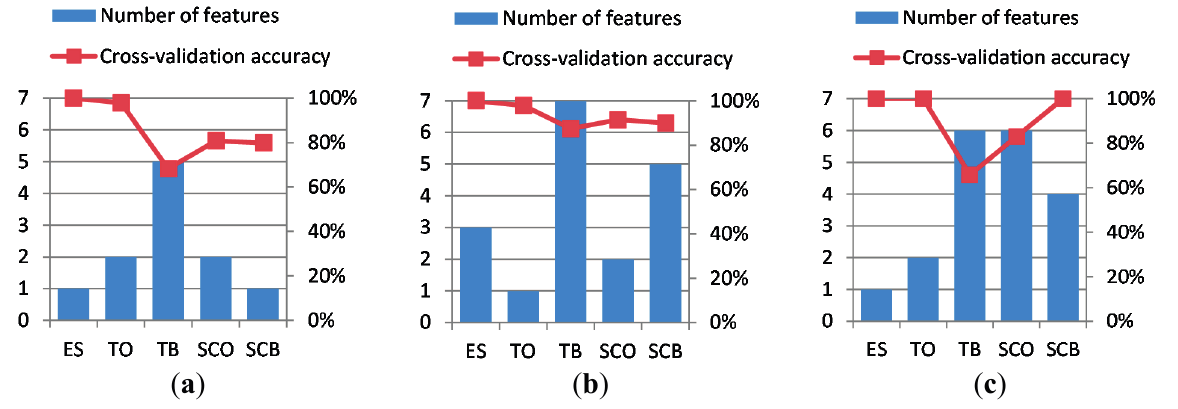
Figure 7. Number of features and cross-validation accuracy for each of the working conditions under consideration—( ES ) engine speed, ( TO ) threshing cylinder operation, ( TB ) threshing cylinder balance, ( SCO ) straw chopper operation, and ( SCB ) straw chopper balance—using the accelerometer channel corresponding to ( a ) the transverse X axis; ( b ) the longitudinal Y axis; and ( c ) the vertical Z